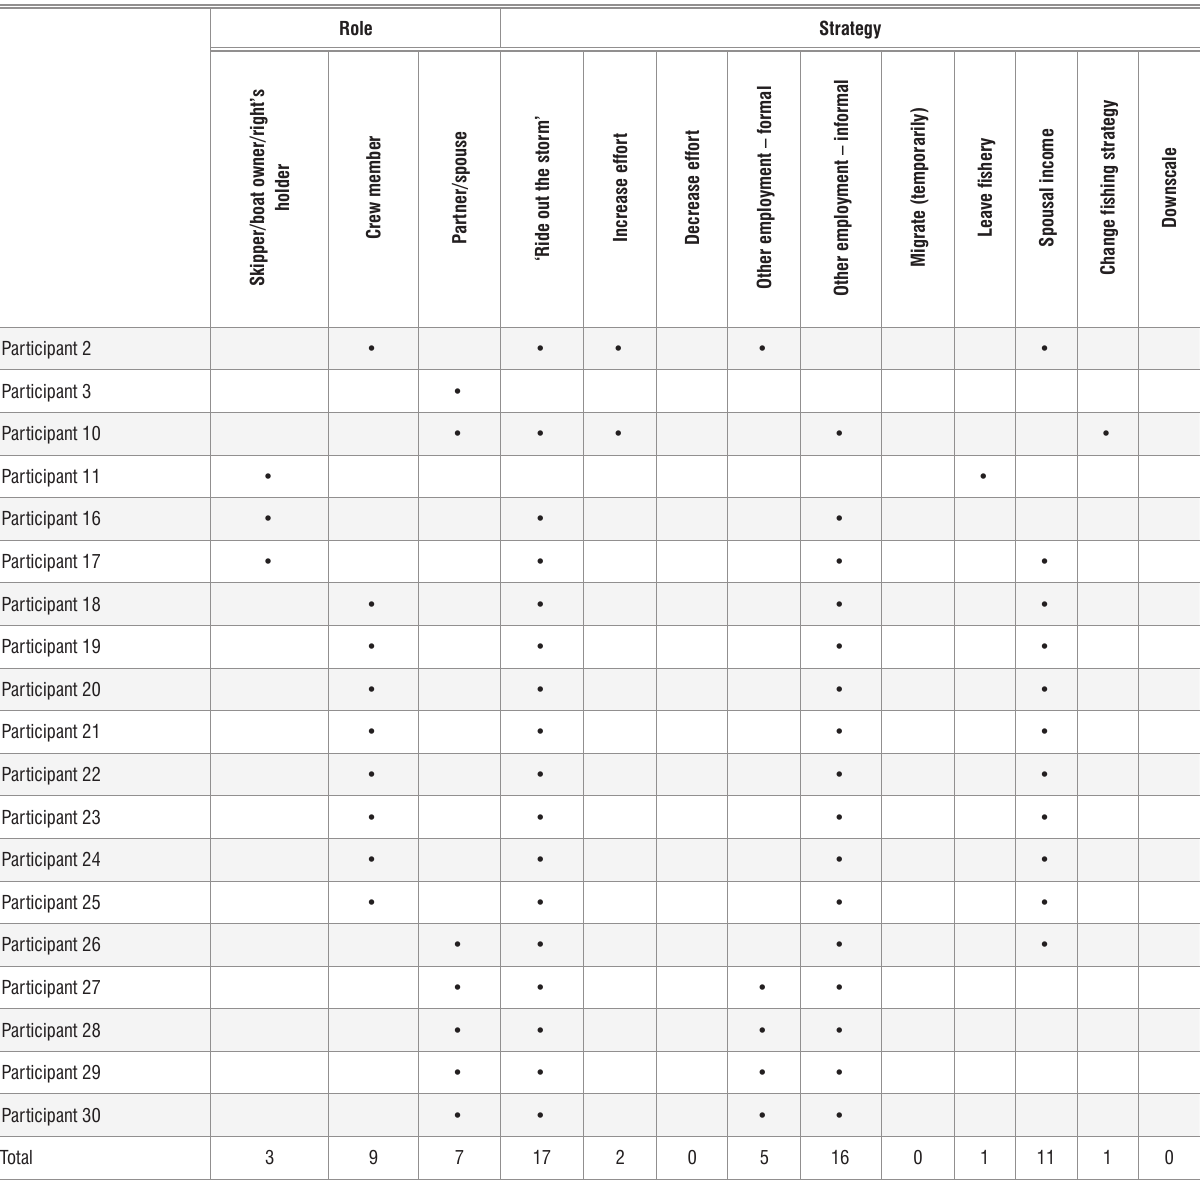
Table 5: Change responses implemented by the fishers from Vermaaklikheid: reacting